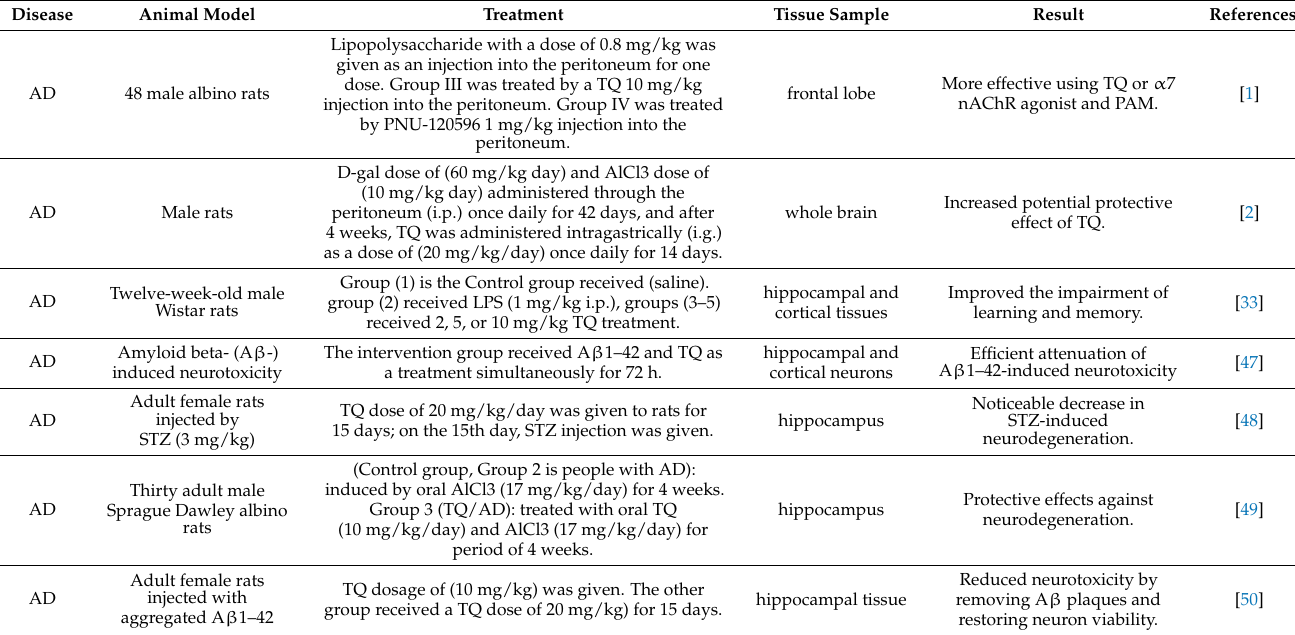
Table 1. Studies on animal models for the effect of Thymoquinone on